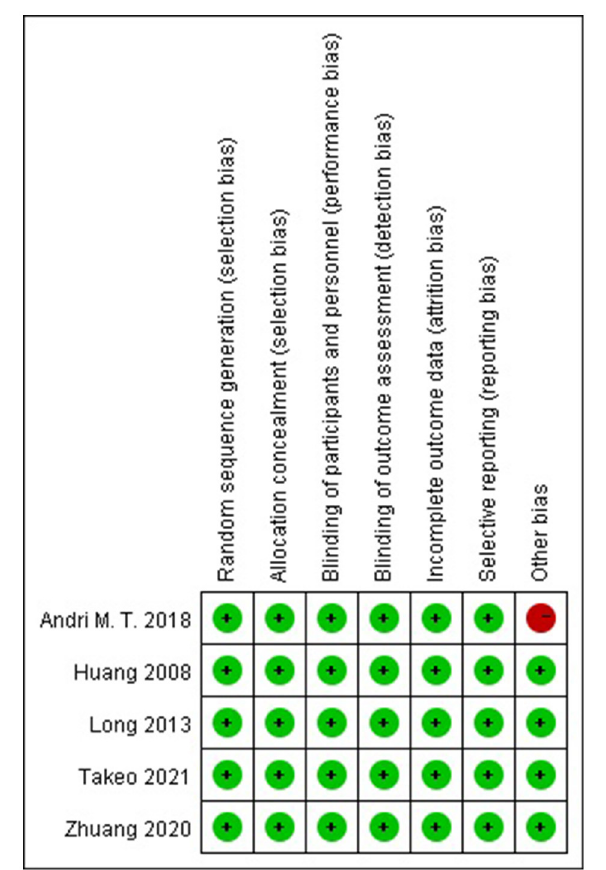
FIGURE 2 | Risk of bias of included